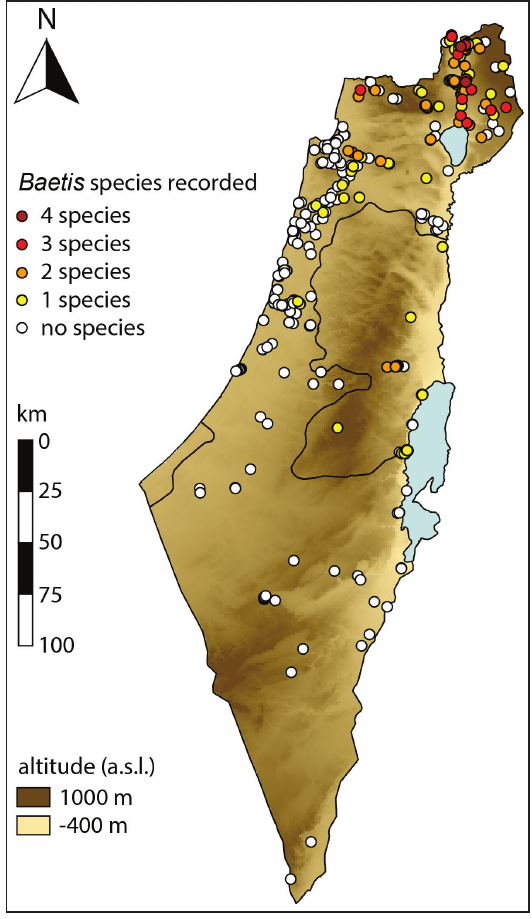
Figure 1. Sampling sites and Baetis species richness in Israel and the Palestinian